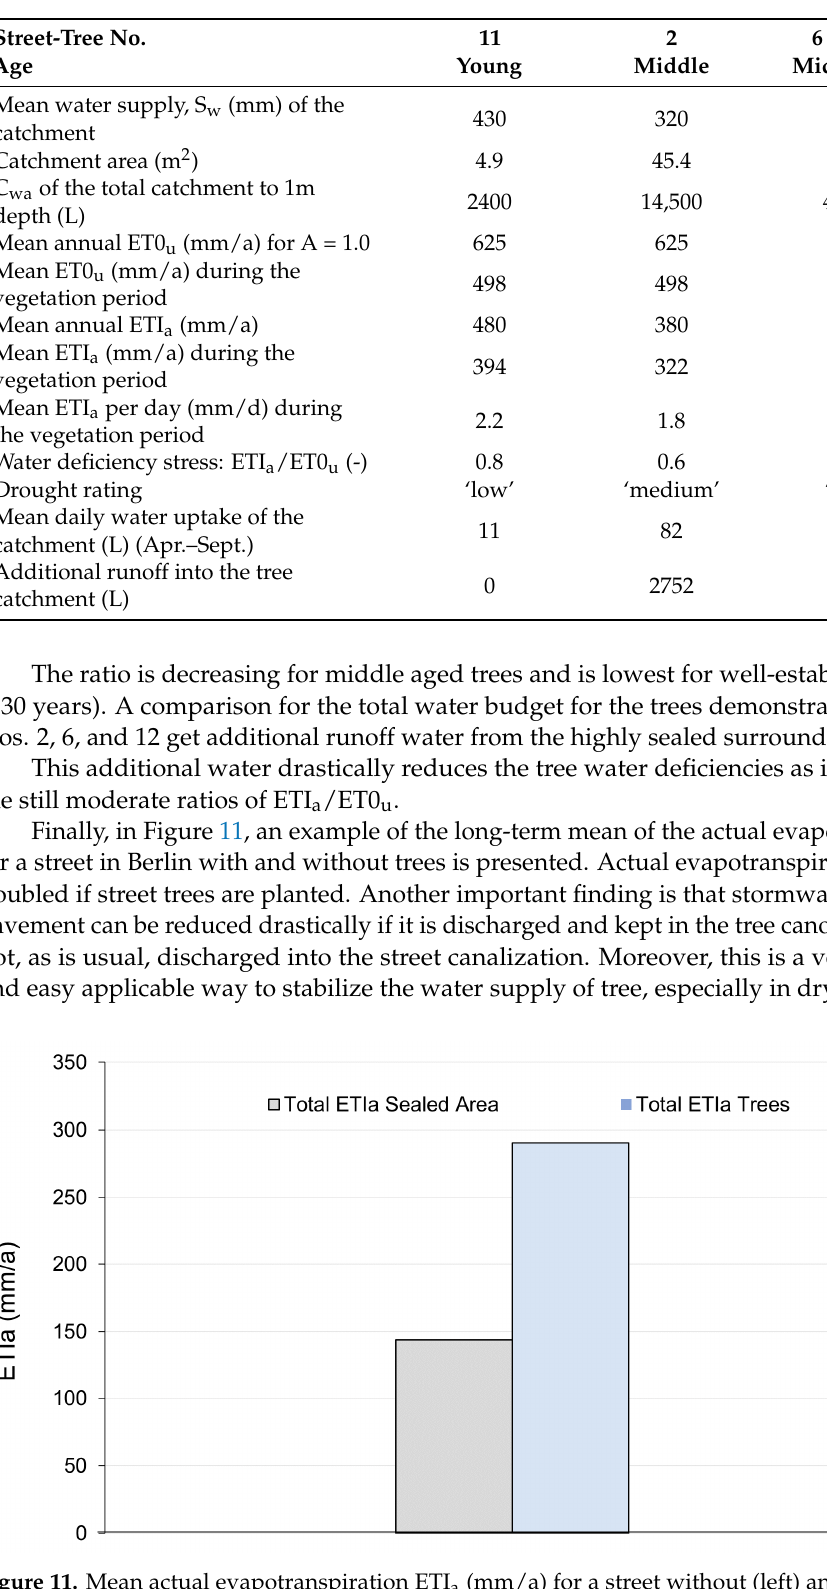
Table 8. Water supply, evapotranspiration, and tree water stress (ETI a /ET0) of three exemplarily street-tree catchments in the Kufsteiner Straße Berlin, Germany.